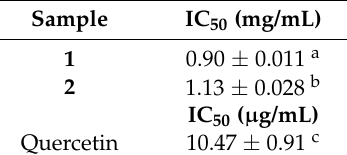
Table 2. Antioxidant activity (IC 50 , mean ± CI 95 , n = 3) by DPPH method of the essential oil from the leaves of A. schaueriana collected at Estaç ã o Ecol ó gica Jureia-Itatins ( 1 ) and Parque Estadual da Ilha do Cardoso ( 2